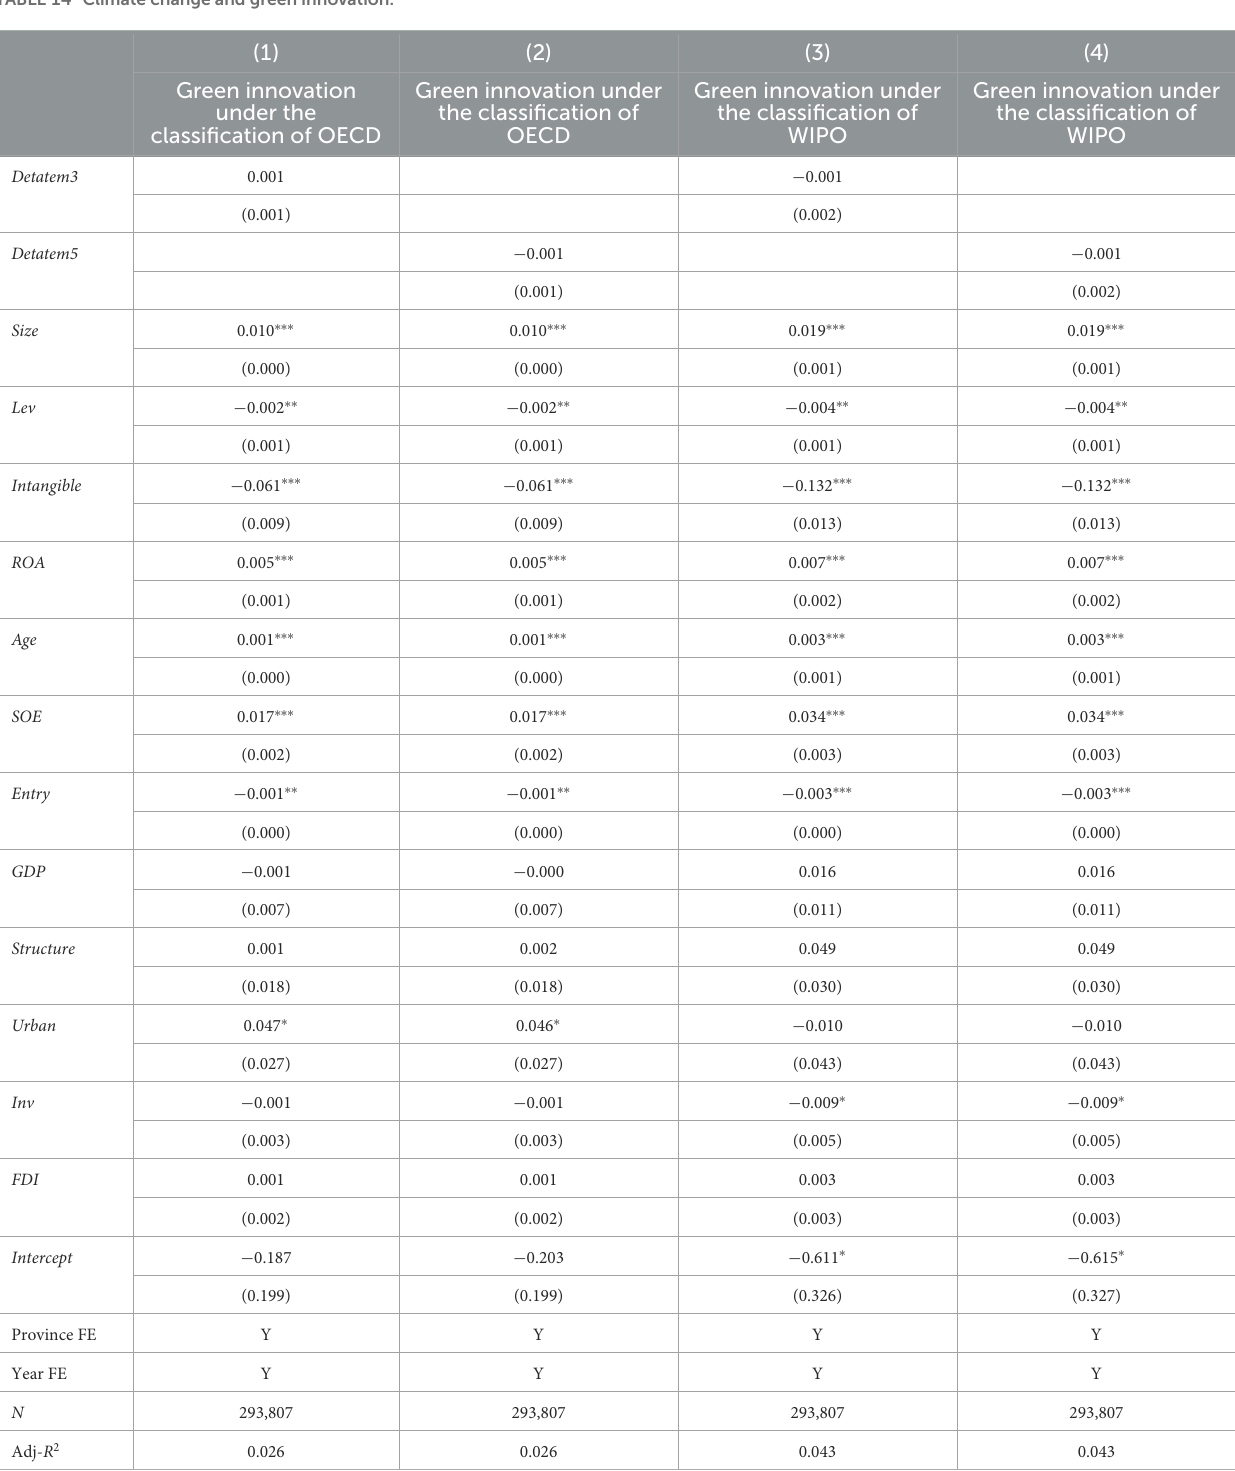
TABLE 14 Climate change and green innovation.